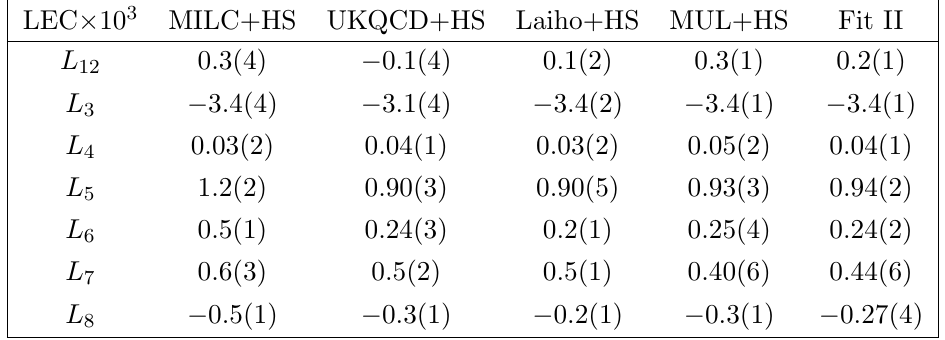
Table 3 . Values of the LECs obtained from the di(cid:11)erent (cid:12)ts to the lattice trajectories m s = k described in the main text. Uncertainties are obtained from the minimization with the MINUIT pro- gram.